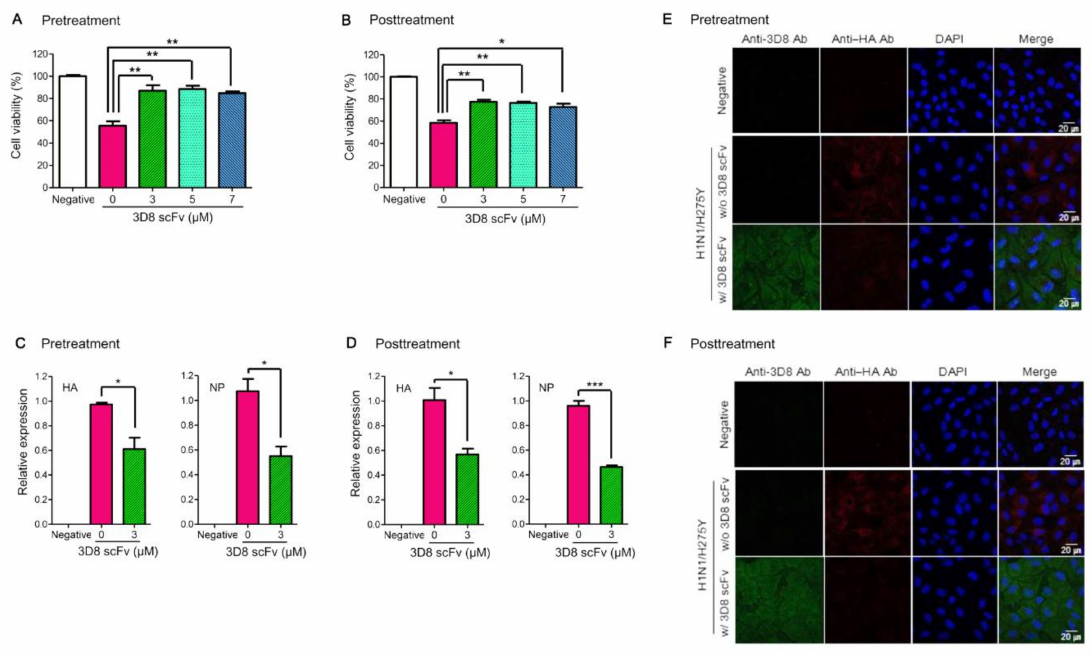
Figure 1. Prophylactic and therapeutic antiviral effects of 3D8 scFv against H1N1/H275Y strains in vitro. ( A , B ) The relative viability of 3D8 scFv-pre/posttreated MDCK cells against viruses at 48 hpi. 3D8 scFv treatment was conducted following the scheme illustrated in Figure S3. Cell viability was measured using an MTT assay. ( C , D ) The relative viral RNA expression ( HA and NP ) in 3D8 scFv (3 µ M)-pre/posttreated MDCK cells against virus at 24 hpi. Data are shown as the mean ± S.E.M. of triplicate samples. Error bars indicate standard error (SE). Asterisks indicate significant differences determined by the t -test (* p < 0.05, ** p < 0.01, *** p < 0.001). ( E , F ) Detection of viral protein (HA) in infected MDCK cells using immunocytochemistry at 24 hpi after 3D8 scFv pre/posttreatment. Nuclei were detected using DAPI (blue), 3D8 scFv with Alexa Fluor 488 (green), and viral HA with TRITC (red). Scale bars represent 20 µ